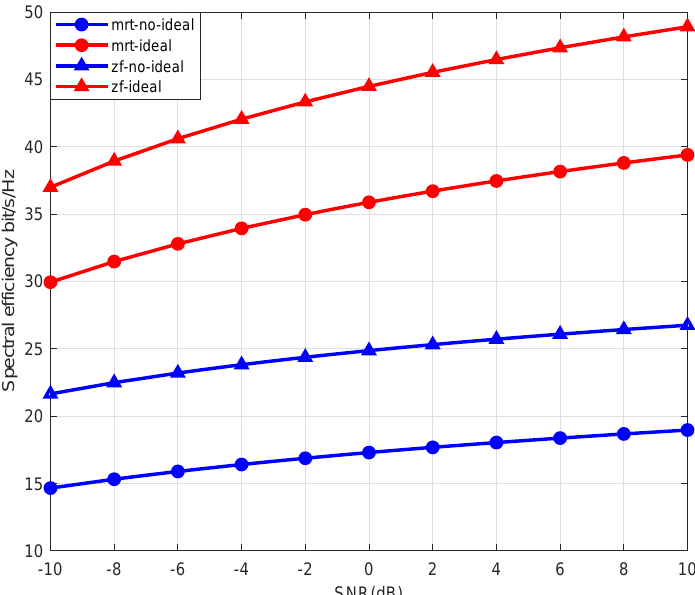
Figure 4. With the help of satellite, when the user’s total rate is constant, part of the rate of ground base station is offloaded to the satellite, resulting that the rate in only terrestrial multicast scene is reduced.